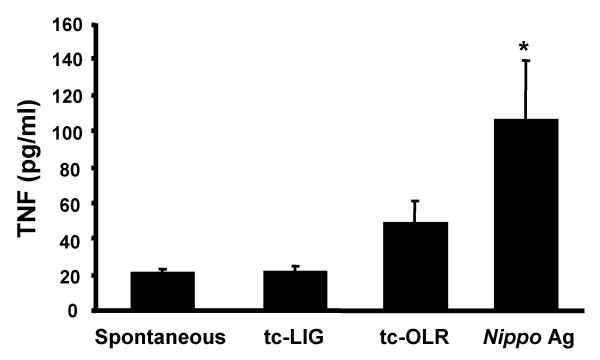
TNF release from PMC (1 × 106 cells) after 8 hr incubation with PAR-2ap (tc-LIG, 10 μM), PAR-2cp (tc-OLR, 10 μM) and Ag (10 We/ml). (Mean ± SEM, n = 4). Star indicates statistically significant difference from spontaneous (p < 0.05, n = 4).